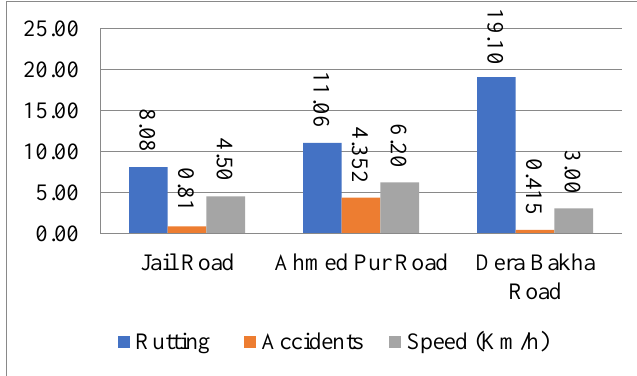
Fig. 13. Bar chart comparing rutting, accident data (1/1000 scale) and speed (1/10